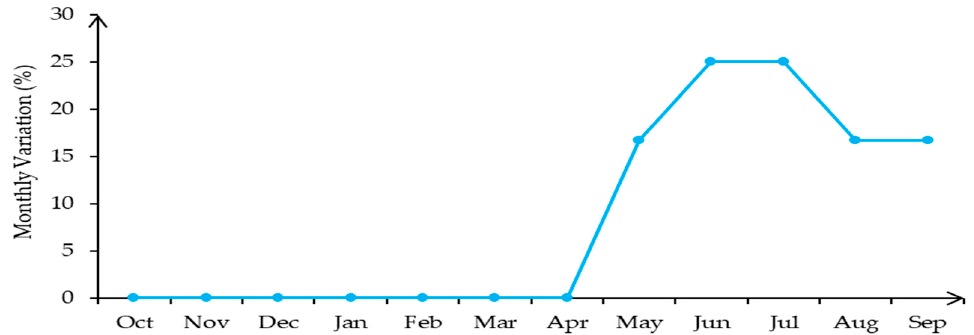
Figure 4. Monthly variation of irrigation water abstraction for Chongwe River Figure 4 . Monthly variation of irrigation water abstraction for Chongwe River catchment .